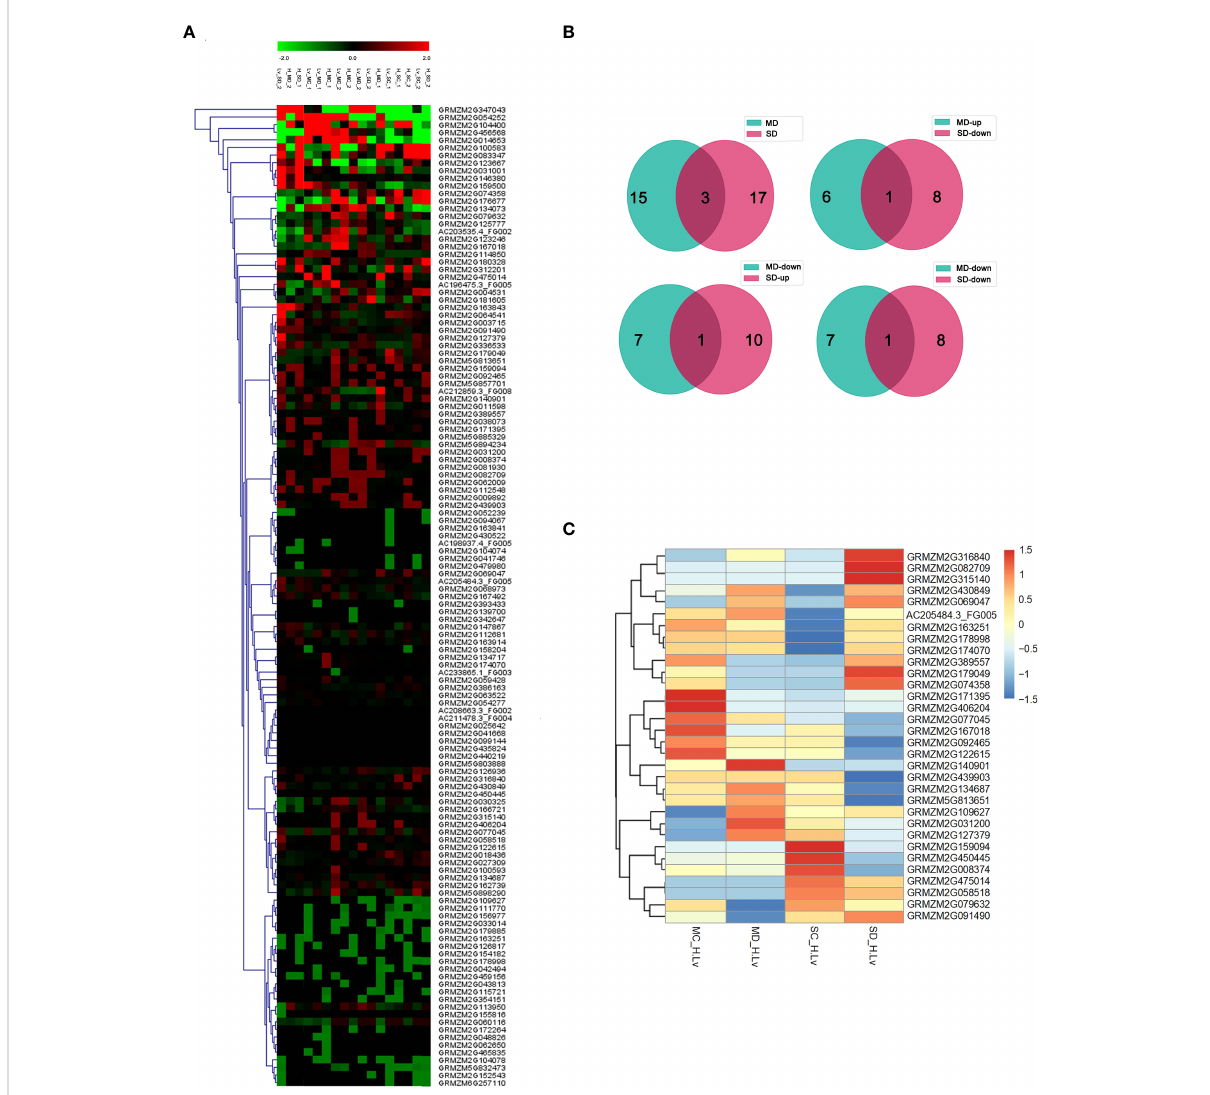
FIGURE 2 Differential expression analysis of maize NAC genes. (A) Heat map analysis of the NAC TF expression under natural soil drought treatments in H082183 and Lv28 based on RNA-seq experiments. Red represents high expression, and green represents low expression. MD, SD, MC, and SC stand for moderate drought, severe drought, moderate drought control, and severe drought control, respectively. (B) Numbers of drought- responsive differentially expressed genes (DEGs) in H082183, compared to Lv28 under the drought stress treatment. MD, moderate drought stress treatment; SD, severe drought stress treatment. (C) Hierarchical clustering based on log2 (fold changeH082183/fold changeLv28) values of